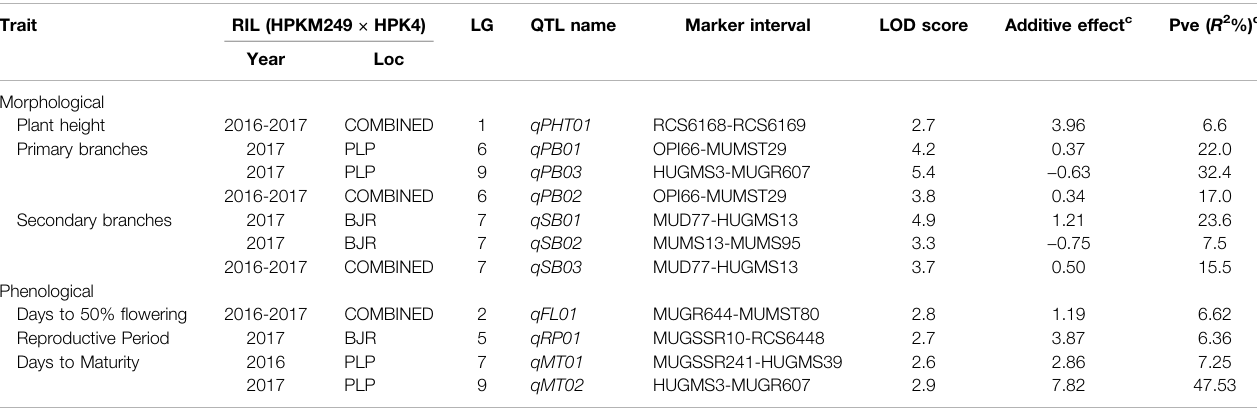
TABLE 6 | QTLs for various drought related traits identi fi ed using QTL Cartographer.